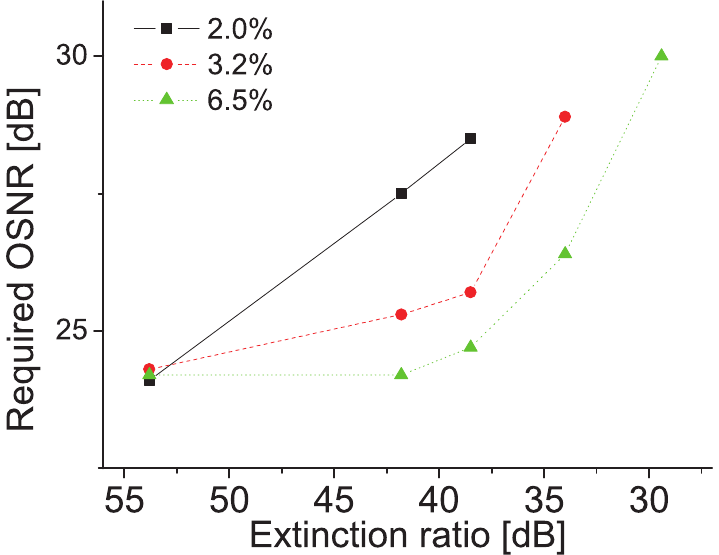
Figure 15. Required OSNR for BER = 10 − 9 , where the modulation depths were 2.0%, 3.2% and 6.5% [12].